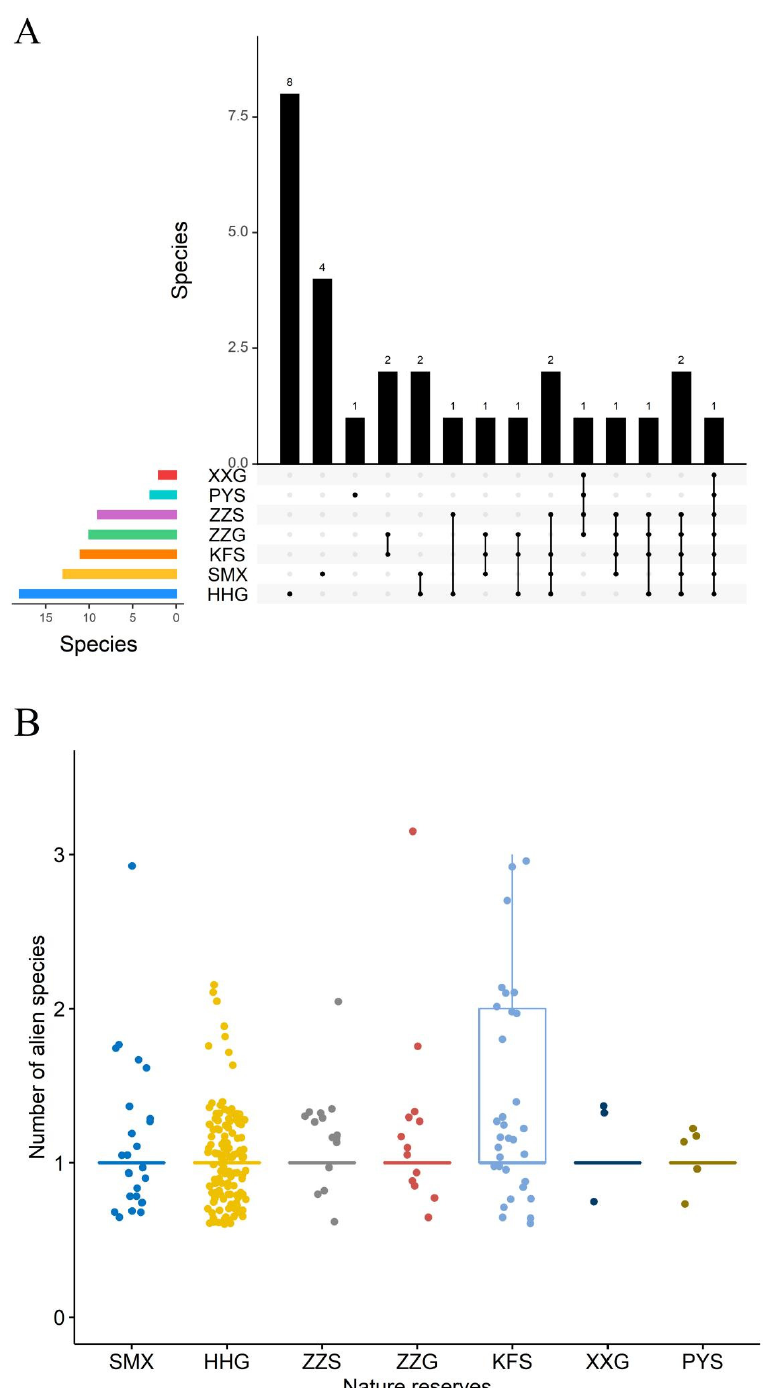
Figure 8. Composition of invasive alien species in the seven nature reserves of the Yellow River in Henan Province, China. ( A ) Venn diagram of invasive alien species in the seven nature reserves; ( B ) Number of invasive alien species in the seven nature reserves. HHG, Henan Yellow River wetland national nature reserve. SMX, Sanmenxia reservoir area wetland. ZZS, Henan Zhengzhou Yellow River wetland provincial nature reserve. ZZG, Henan Zhengzhou Yellow River national wetland park. KFS, Henan Kaifeng Liuyuankou wetland provincial nature reserve. XXN, Henan Xinxiang Yellow River wetland birds national nature reserve. PYS, Henan Puyang Yellow River wetland provincial nature